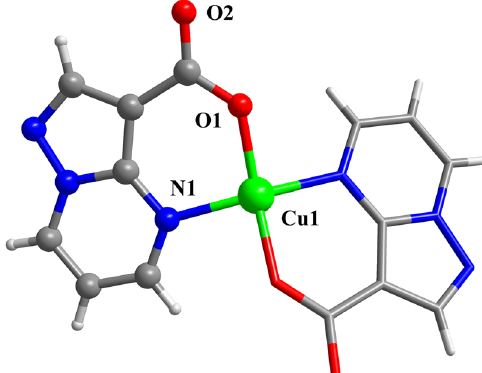
Table  : Data collection and